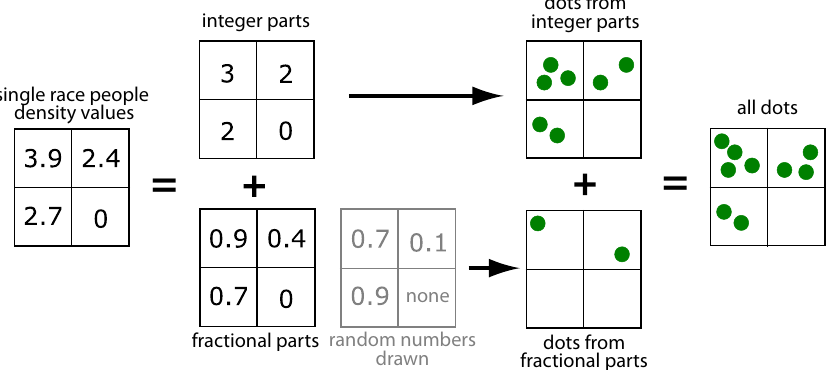
Figure 2. Illustration of the procedure to assign a given race dots to a grid cell. See the main text for